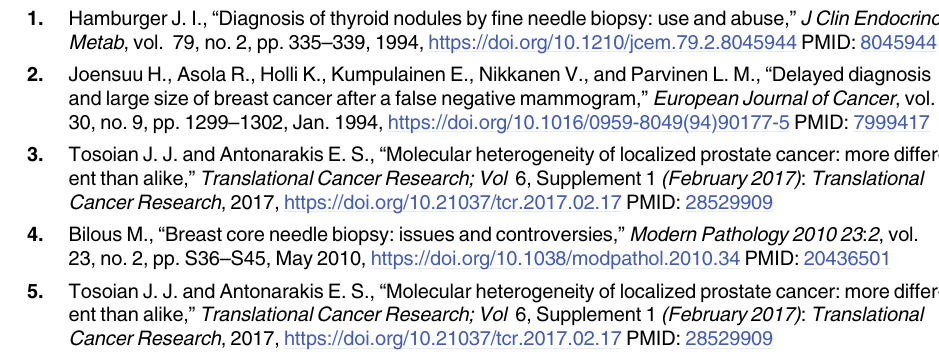
S1 Table. Electric and thermal properties of the mice healthy brain tissue and melanoma tissue used in numerical